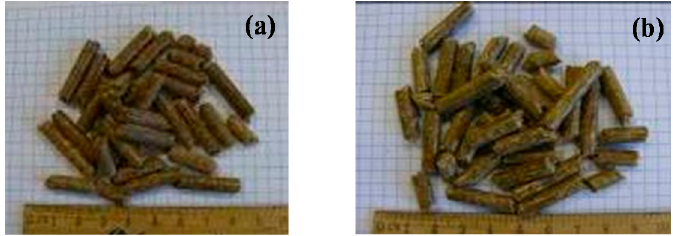
Figure 7. Visual comparison of both types of pellets. ( a ) Image of pellet from almond tree; ( b ) Image of pellet from olive tree.